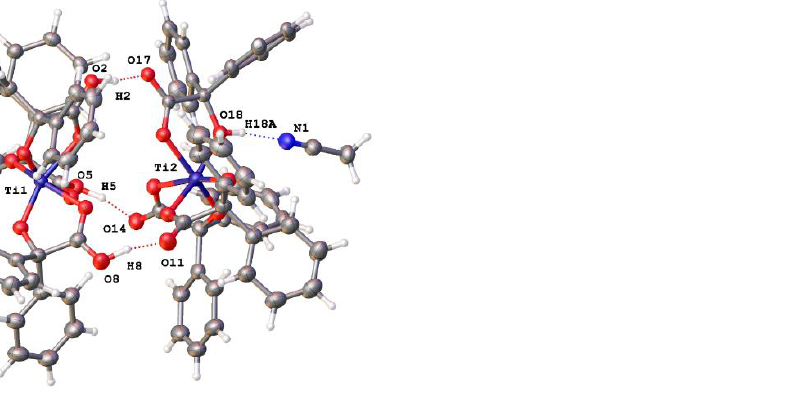
Figure 3. Asymmetric unit of 3 . For clarity, atoms are drawn as spheres of arbitrary radius, minor disorder is not shown, and hydrogen atoms are not shown. Selected bond lengths (Å ) and bond angles ( o ): Ti(1)-O(1) 2.136(8), Ti(1)-O(3) 1.888(9), Ti(1)-O(7) 1.832(9), Ti(1)-O(8) 1.697(10), Ti(1)-O(9)